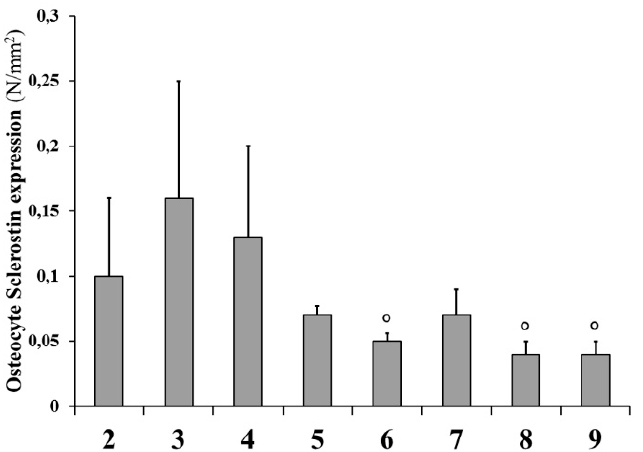
Figure 12. Sclerostin expression of osteocytes in the cortical bone of the anterolateral portion of the L4 vertebral body. The number (N) of stained osteocytes was related to the area (mm 2 ) examined in each microscopic field. Values are expressed as mean ± S.D. ANOVA followed by Bonferroni’s test. ° p < 0.05 versus Group 3.